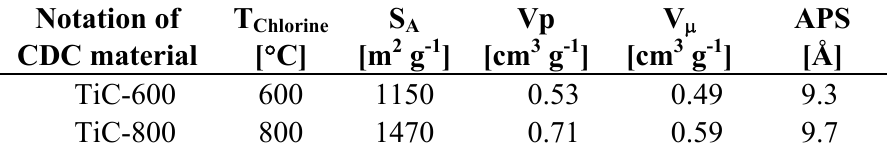
Table 2. Some physical parameters of TiC derived